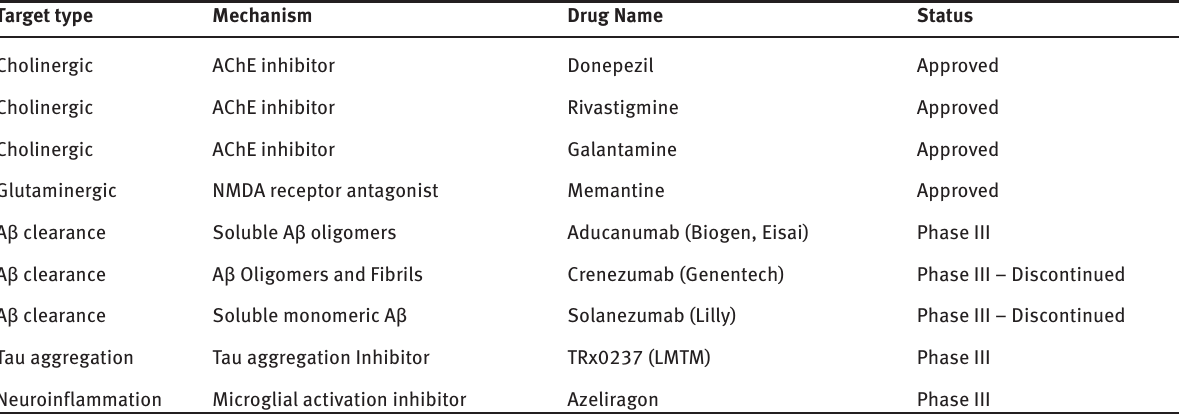
Table 1: Current Disease-Modifying Therapies for Alzheimer’s Disease.*